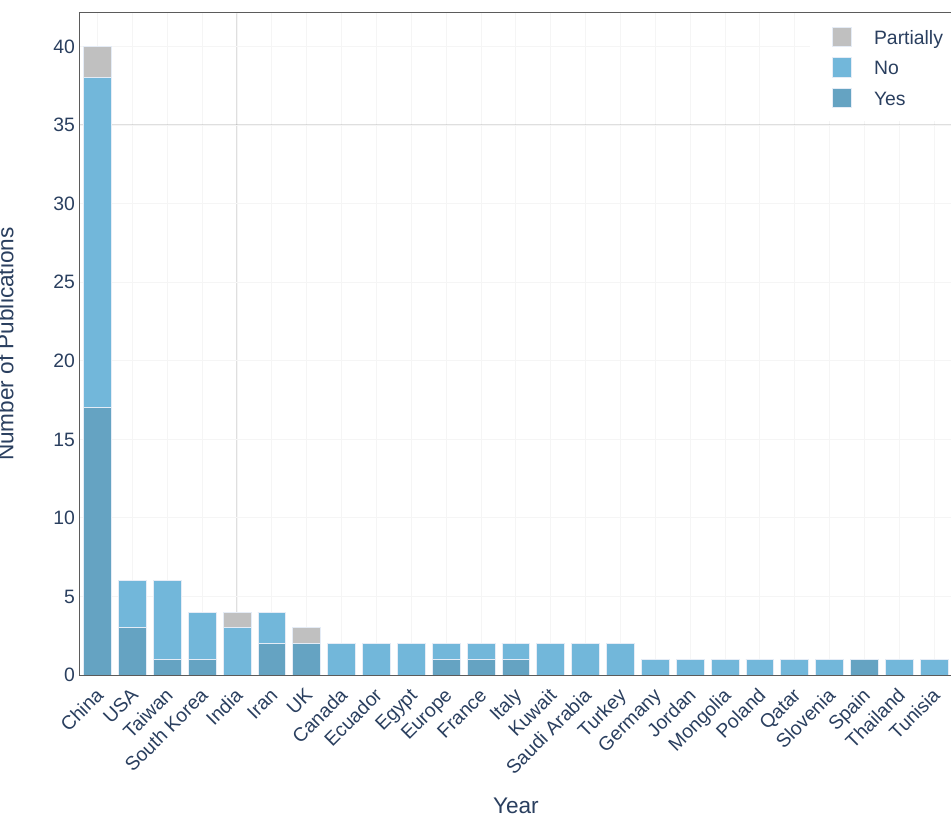
Figure 9. Data availability per case